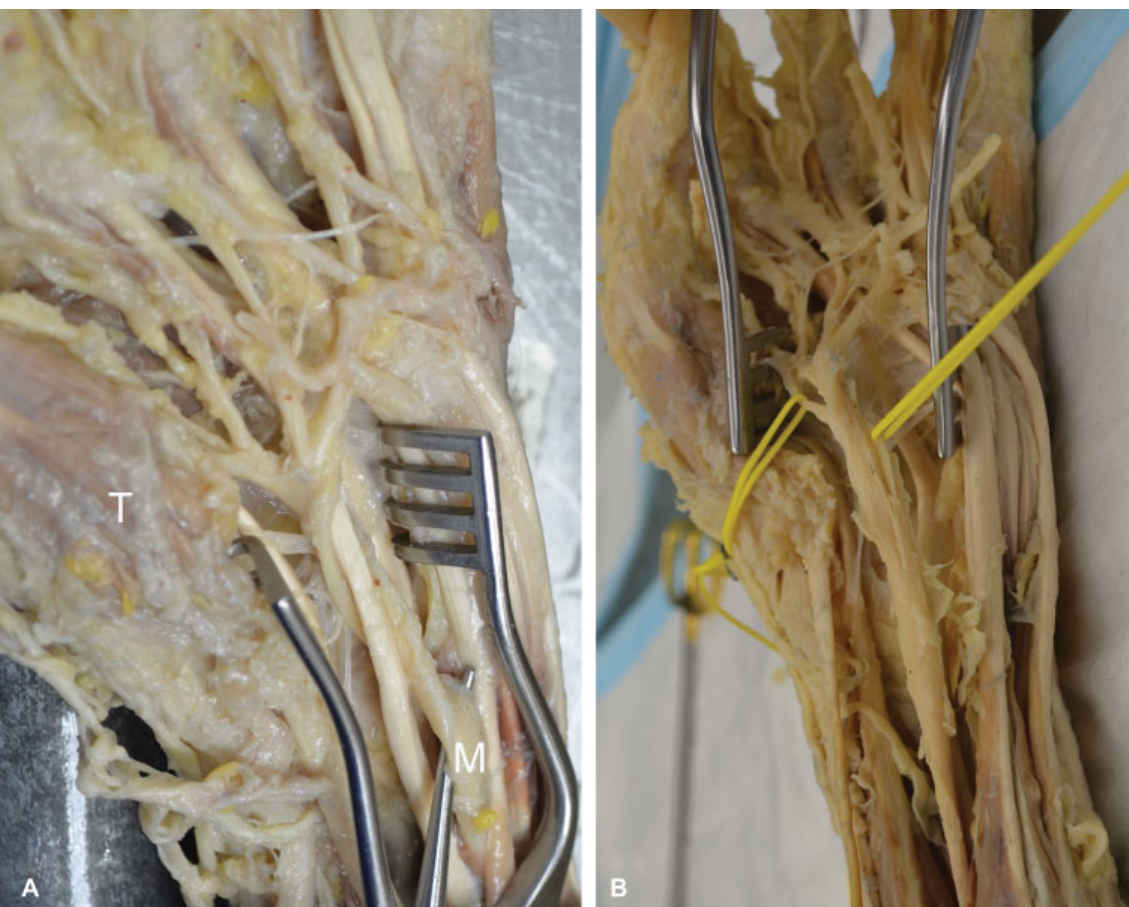
Fig.2 ( A )Whenthe fl exortendonswereretracted,themediannerve(M)wasobservedmakinga360-degreespiralturndeeptotheFDStendonstoemerge lateraltothen super fi cial to FDS. ( B ) Interfascicular dissection showing the palmar recurrent branch (yellow vessel loops) moving from medial tolateral on the deep surface of the median nerve toward its destination to the thenar muscles. FDS, fl exor digitorum super fi cialis; T, thenar